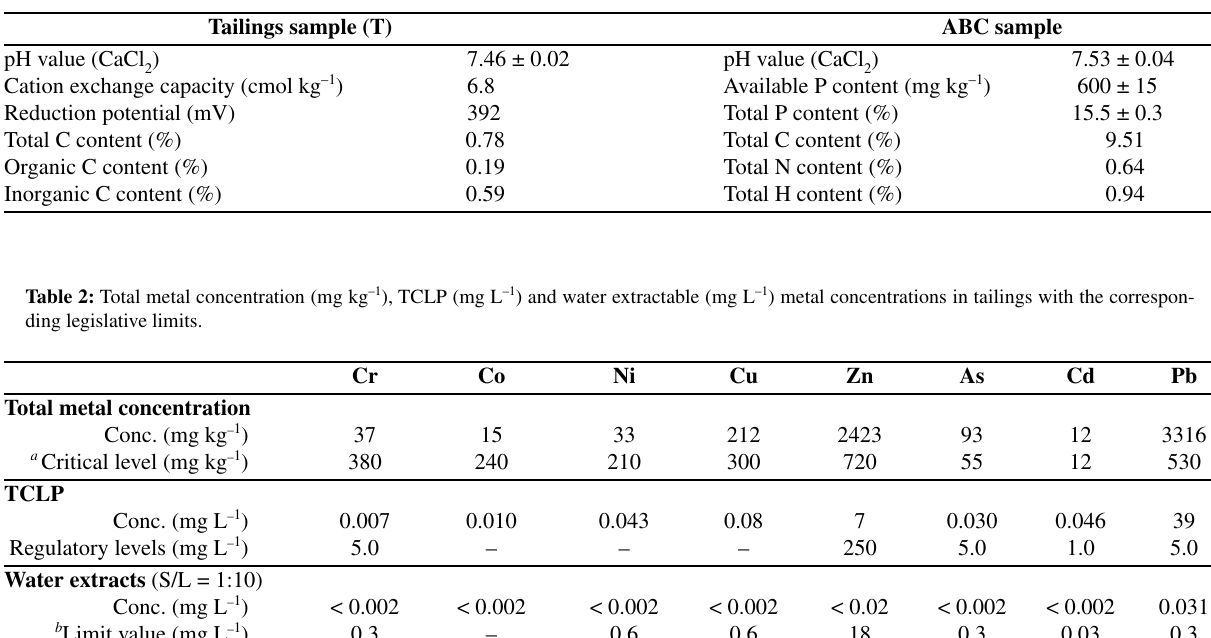
Table 1: Physicochemical properties of the mine tailings and ABC.